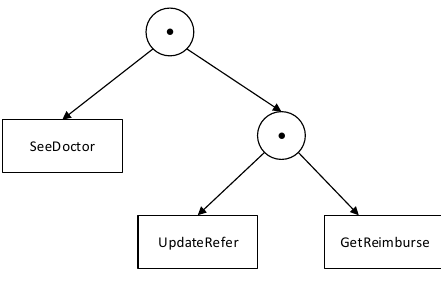
Figure 4. An incident tree for SeeDoctor